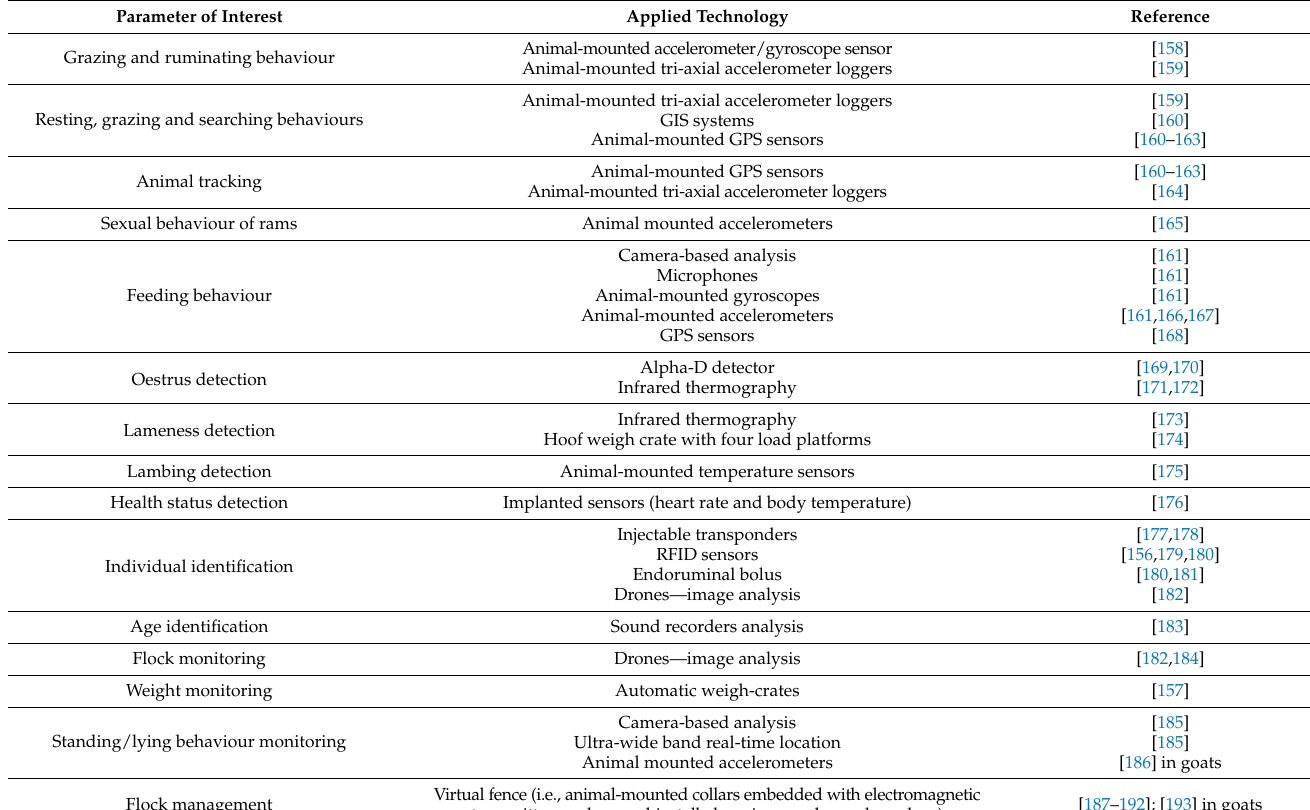
Table 2. Application of precision livestock farming advancements to sheep and